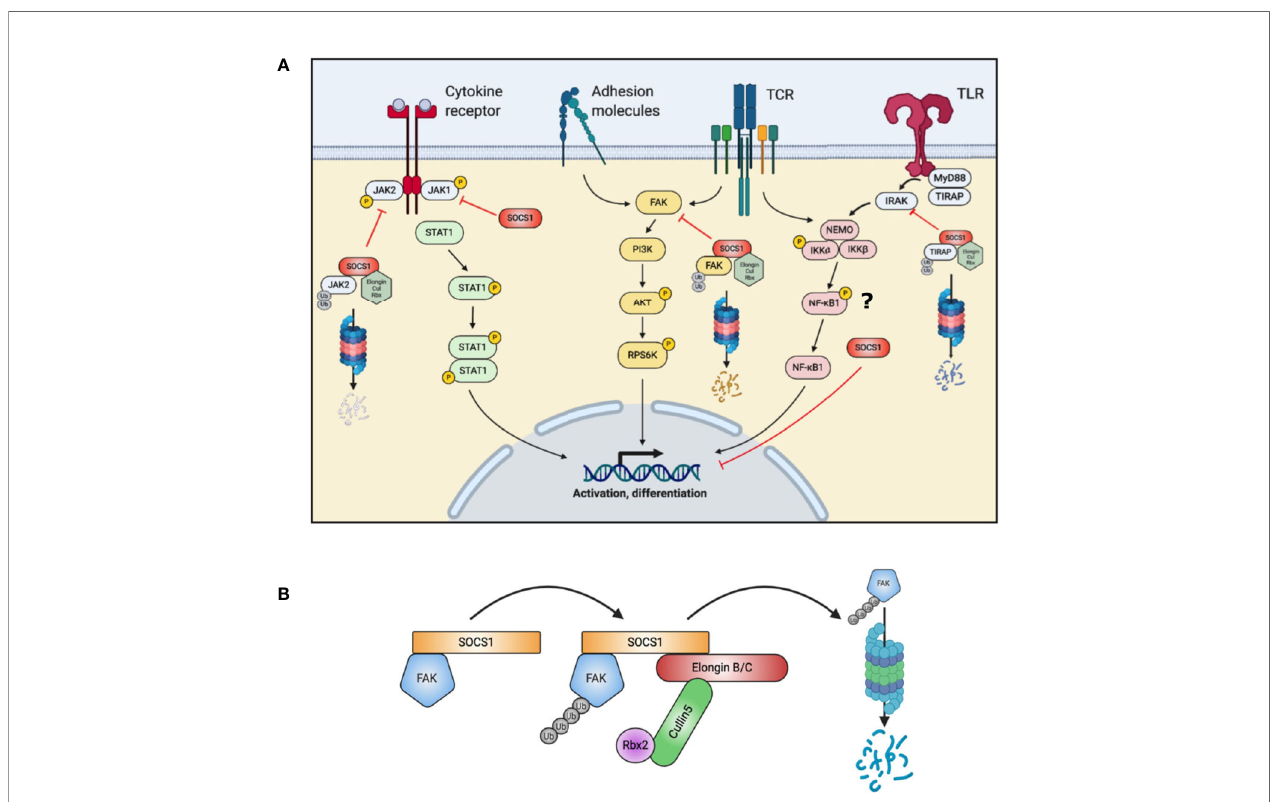
FIGURE 1 | Summary of SOCS1 actions in T cells. (A) SOCS1 acts on multiple intracellular pathways, both by directly binding and blocking a target (JAK, NF- k B1) and as a substrate for the formation of an E3 ubiquitin ligase to target proteins for proteasomal degradation (FAK, TIRAP). (B) Simpli fi ed schematic of SOCS1 E3 ligase complex assembly with FAK (Focal adhesion kinase) accomplishing ubiquitination of signaling intermediates. AKT, Protein kinase B; Cul, Cullin; FAK, Focal adhesion kinase; IKK, inhibitor of nuclear factor kappa-B kinase; IRAK, Interleukin-1 receptor associated kinase; JAK, Janus kinase; MyD88, Myeloid differentiation primary response 88; NEMO, NF-kappa-B essential modulator; NF k B, nuclear factor kappa-light-chain enhancer of activated B cells; PI3K, Phosphoinositide 3 Kinase; Rbx, RING-box protein; RPS6K, Ribosomal protein s6 kinase; SOCS, suppressor of cytokine signaling; STAT, signal transducer and activator of transcription; TCR, T cell receptor; TIRAP, toll-interleukin 1 receptor (TIR) domain containing adaptor protein; TLR, Toll-like receptor; Ub,